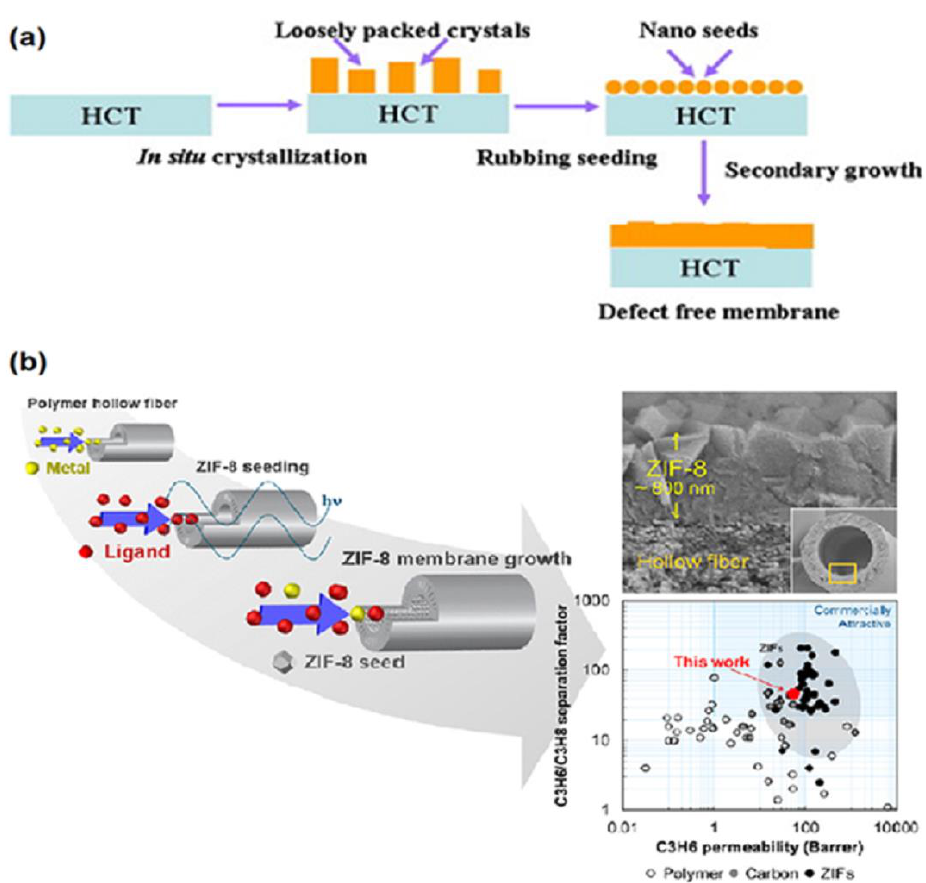
Figure 2. Schematic representations of the secondary growth of MOF membranes: ( a ) physical seed- ing and ( b ) chemical seeding. Reprinted with permissions from Refs.